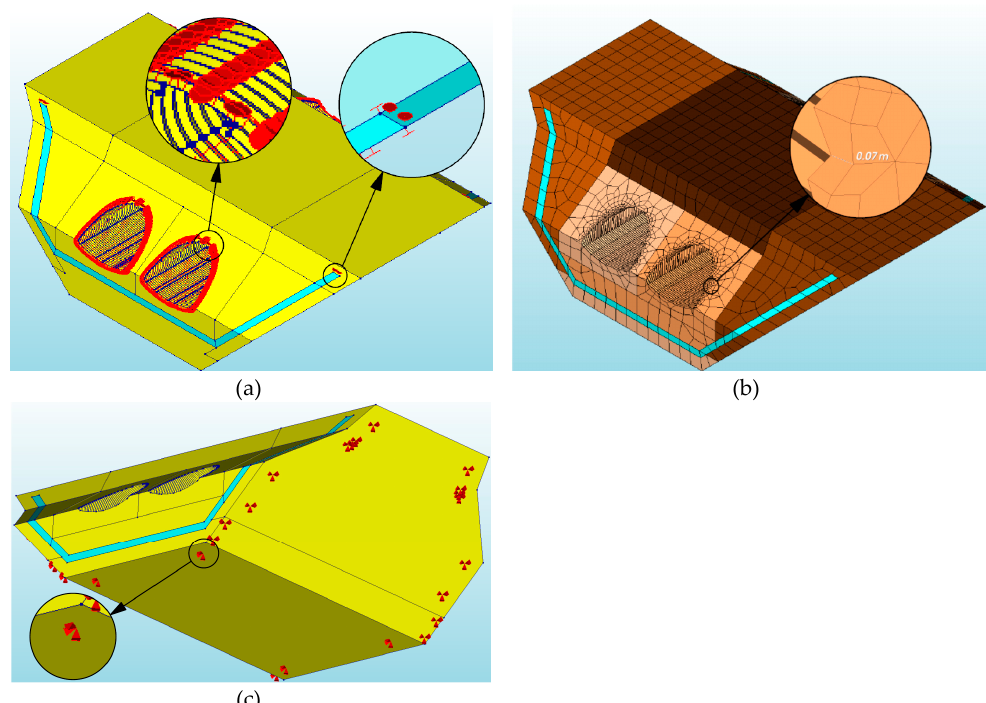
Figure 6. View of numerical model of the soil–steel bridge: ( a ) Connection-interface, ( b ) mesh, ( c ) boundary conditions (hinged